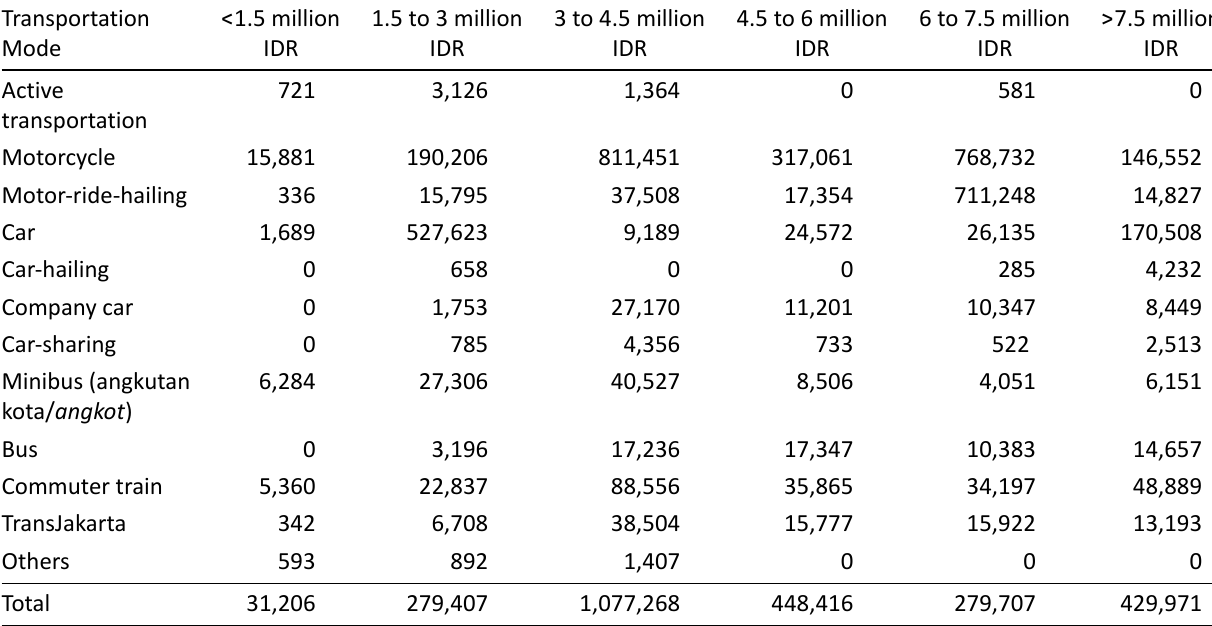
Table 1. Salary range proportion (in million IDR), by transportation mode.